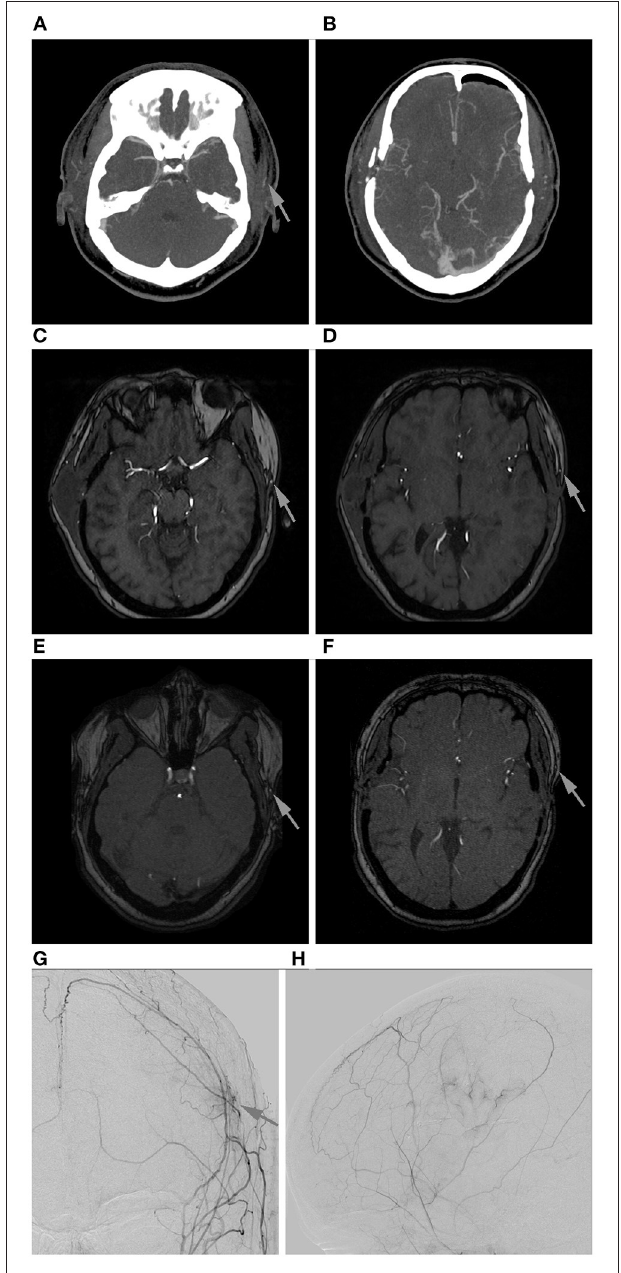
in DSA. (A,B) : Early post-operative CTA. Only the frontal branch of the STA is contrasted (arrow). (C,D) : MR-TOF after 3 months. Only the frontal branch of the STA is contrasted (arrows). (E,F) : MR-TOF after 6 months. Only the frontal branch of the STA is contrasted (arrows). (G,H) : Angiogram of the external carotid artery anterior-posterior (G) and lateral (H) with only little cortical perfusion at the site of revascularization (arrow; vessel sprouting caused by indirect revascularization with additional EGPS (MCA territory) and in the ACA territory (spontaneous collateralization caused by the middle meningeal artery).